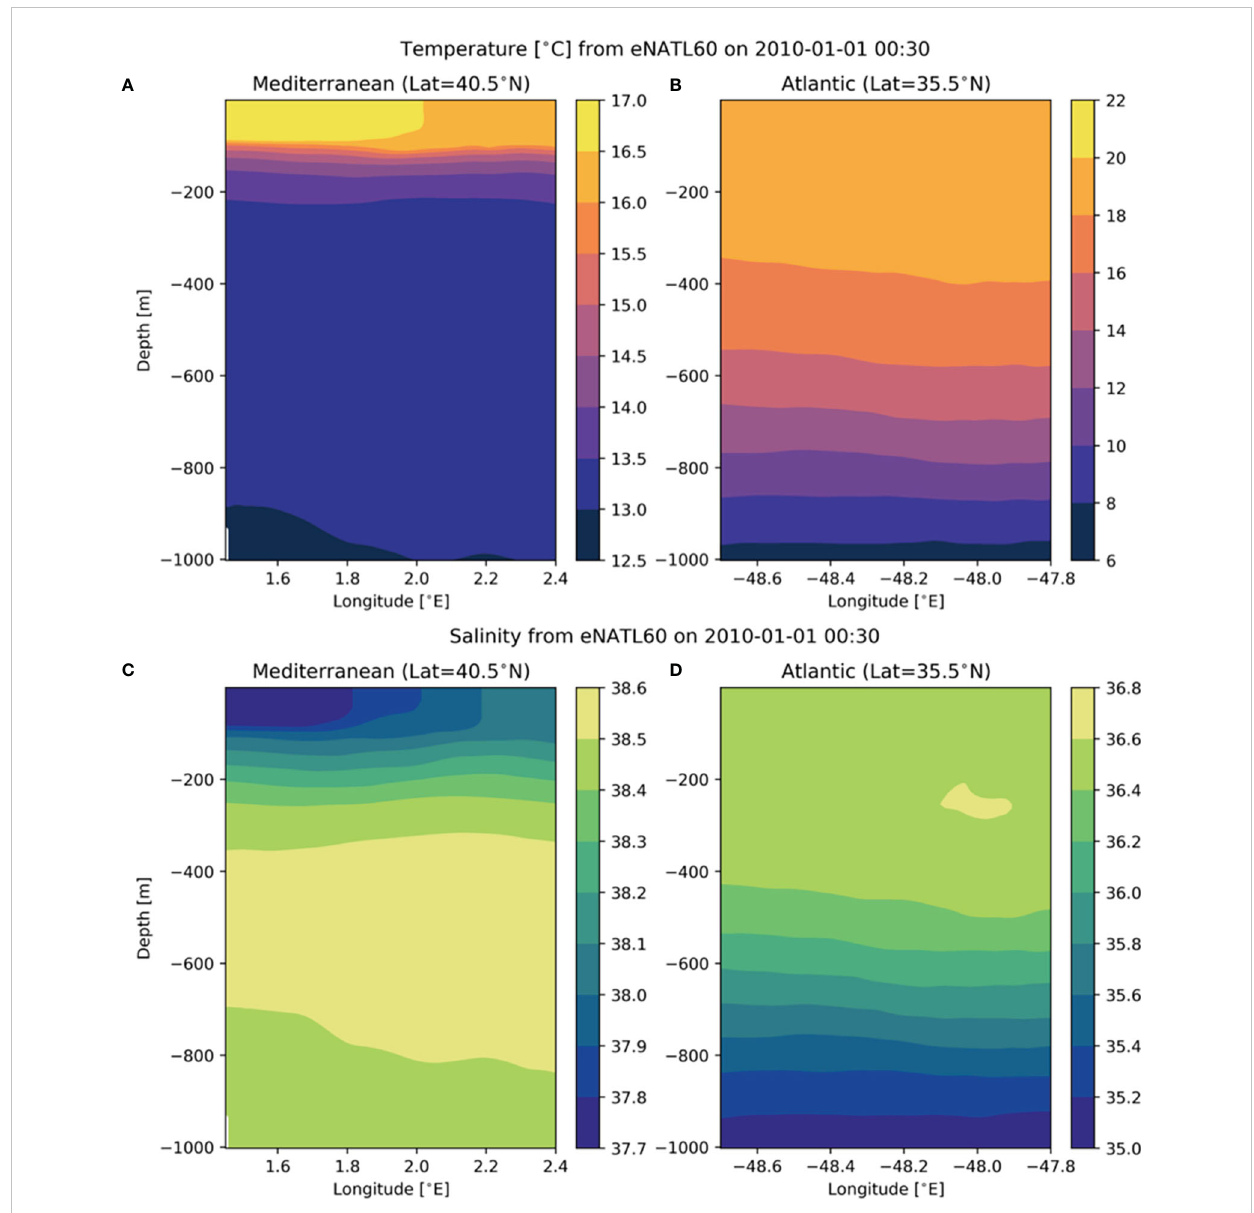
FIGURE 7 Zonal sections of (A, B) temperature and (C, D) salinity in the two regions of study from eNATL60 (1 January 2010,